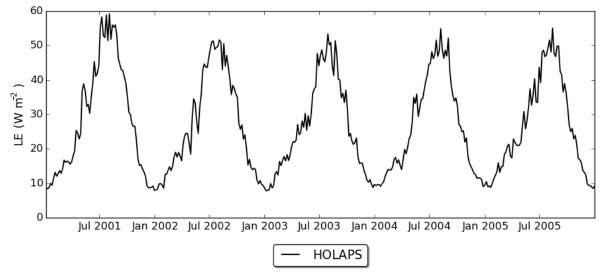
Figure 8. Temporal variability of the area-averaged LE for 5-day HOLAPS over the TP.